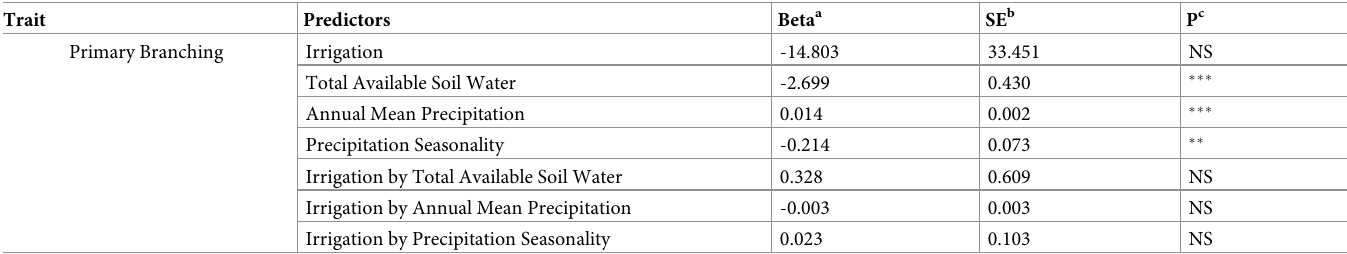
Table 5. Multivariate regression analysis of Mexican chile pepper accessions from a greenhouse soil water deficit experiment on chile pepper ( Capsicum sp.) at the Ohio State University. The relationship between mean primary branching and environmental parameters related to precipitation from the originating environment are presented (R 2 =